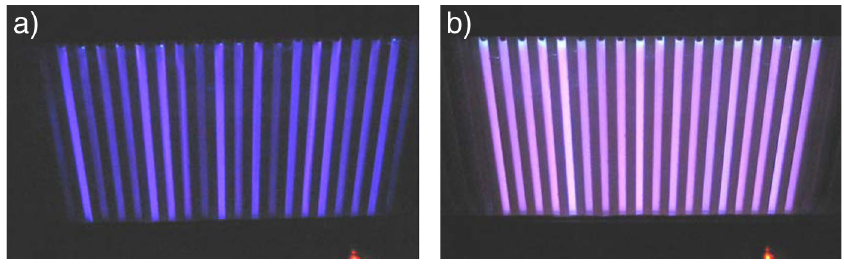
FIG. 10. (Color) High-voltage discharge inside diffraction grating: (a) amplitude of high-voltage pulse 50 kV; (b) amplitude of high- voltage pulse 100 kV, distant between plasma layers is equal 6.9